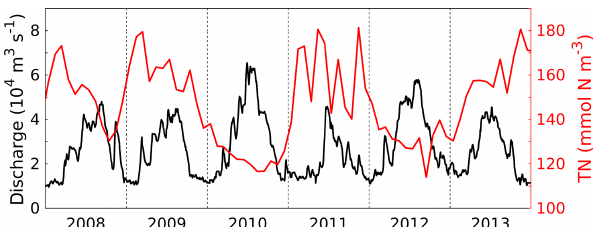
Figure 2. Time series of daily freshwater discharge (black, left y axis) and monthly total nitrogen (TN) concentration (i.e., the sum of the riverine concentrations of all N variables: NO − and large detritus, dissolved organic matter, phyto- and zooplank- ton) in the Changjiang (red, right y